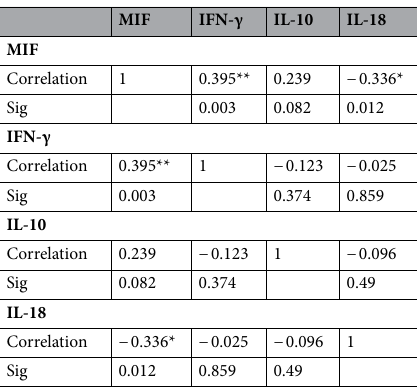
Table 4. BAL cytokines correlations. *Correlation is significant at the 0.05 level (2-tailed). **Correlation is significant at the 0.01 level (2-tailed).